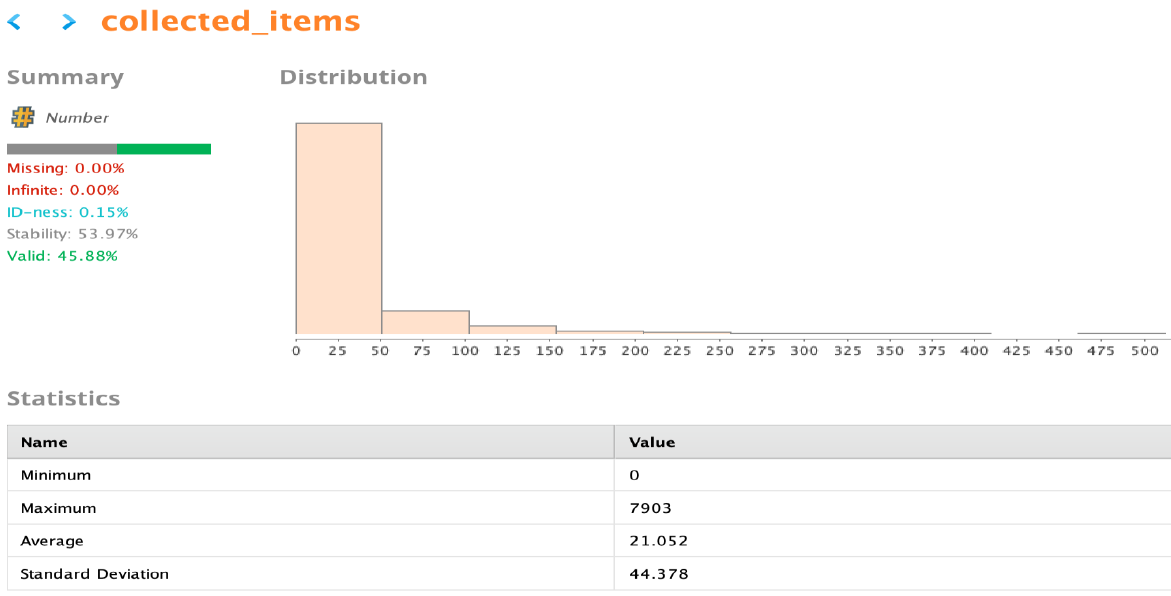
Figure 3. Attribute statistics detail for the traditional approach using RapidMiner.